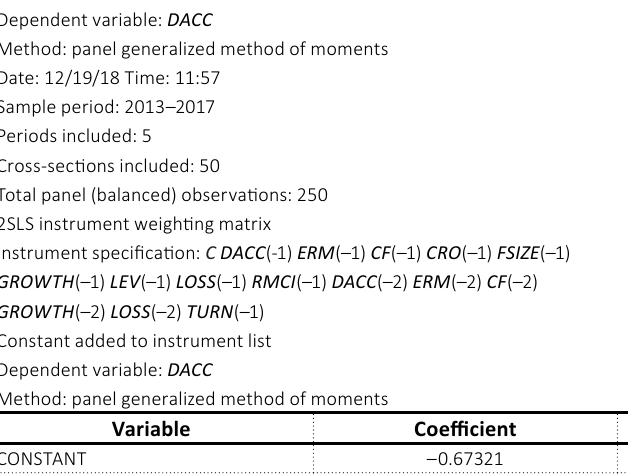
Source: Authors’ computation (2018) using